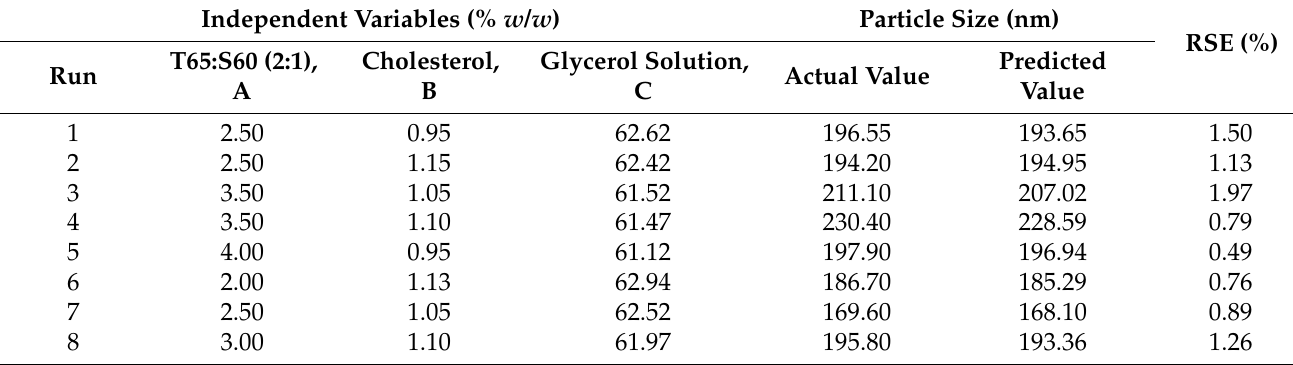
Table 5. Validation sets of niosome formulation.